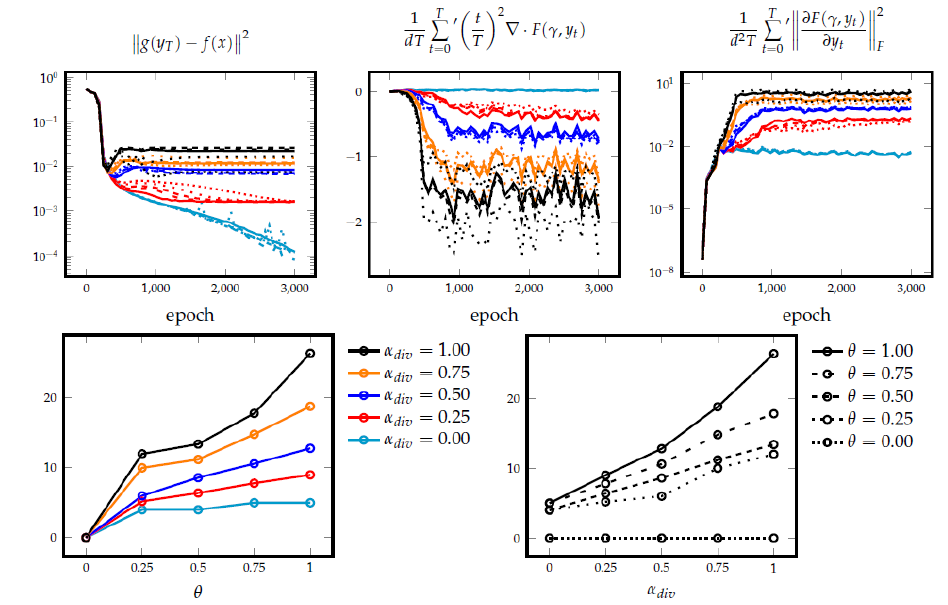
Figure 8. ( Top ) Evolution of the training loss components in (21) for Example 1. ( Bottom ) Nonlinear iterations per residual layer of the trained network.